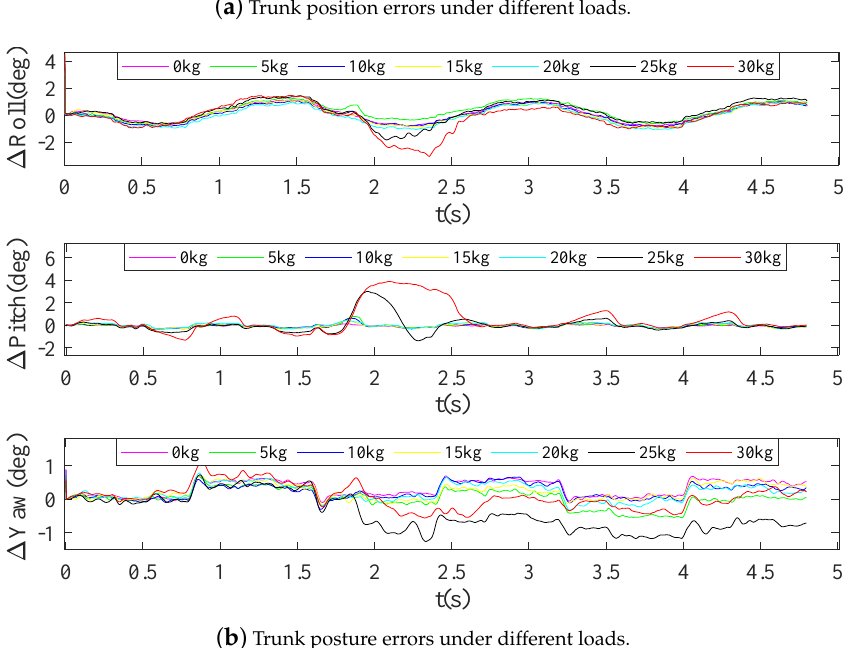
( a ) Trunk position errors under different loads.